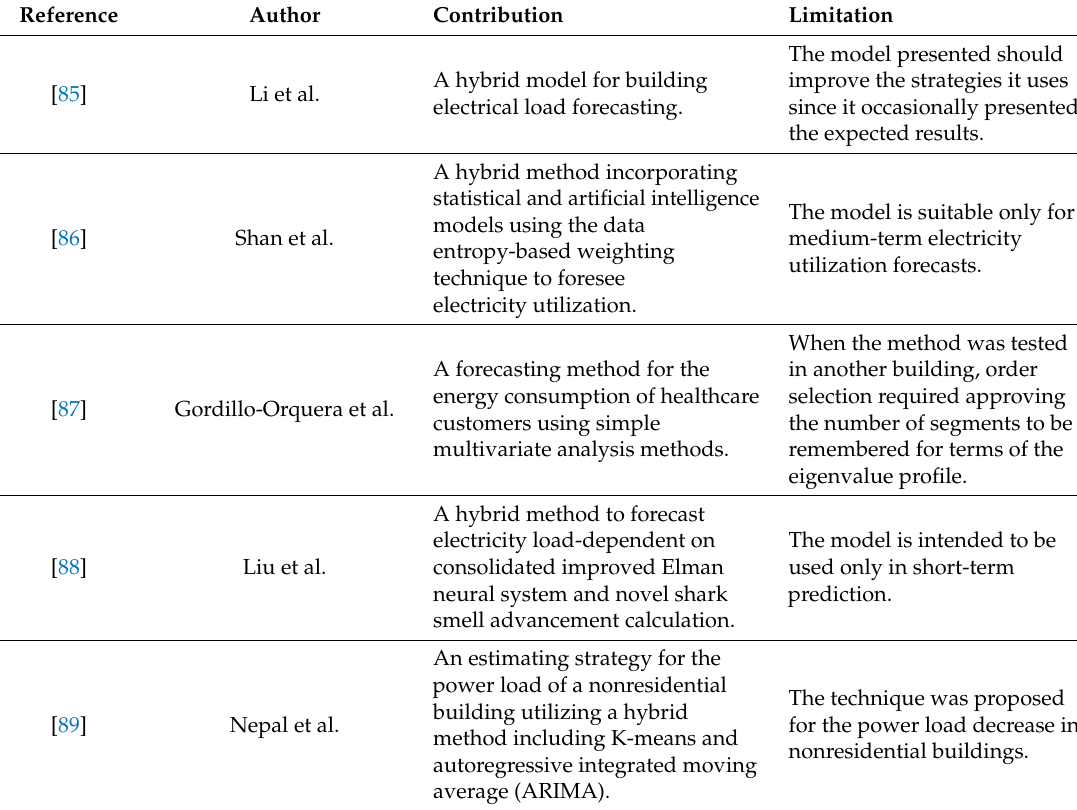
Table 3. Summary of previous research papers and their contributions to hybrid